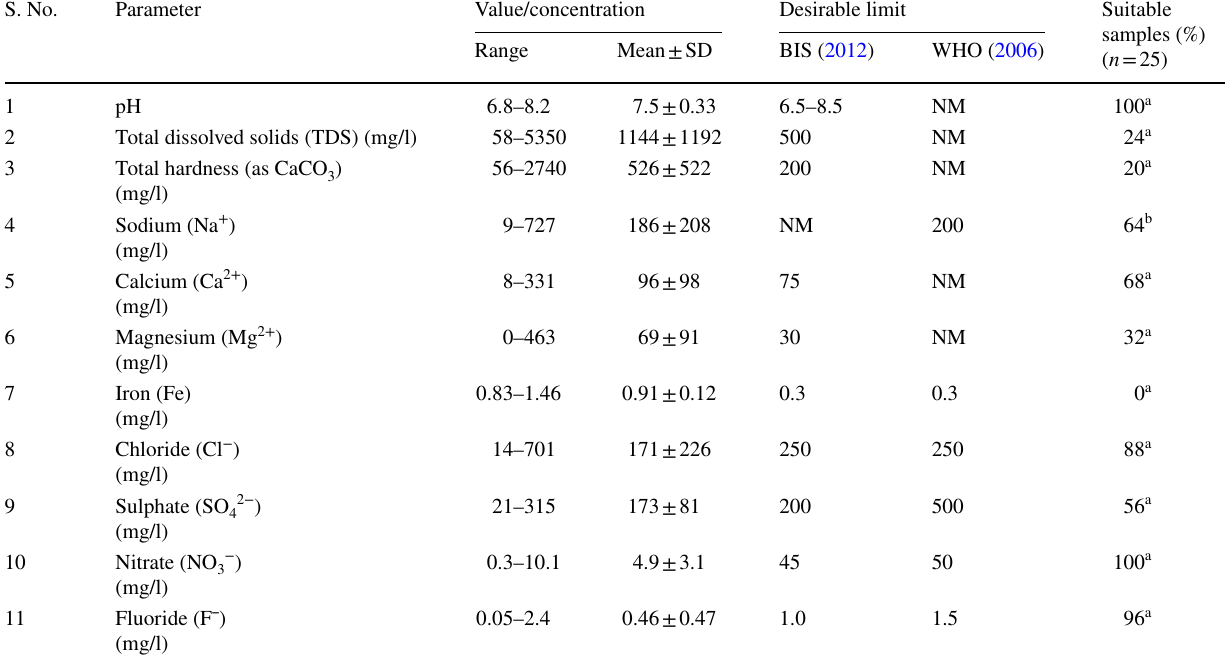
Table 2 Suitability of groundwater for drinking in the present study